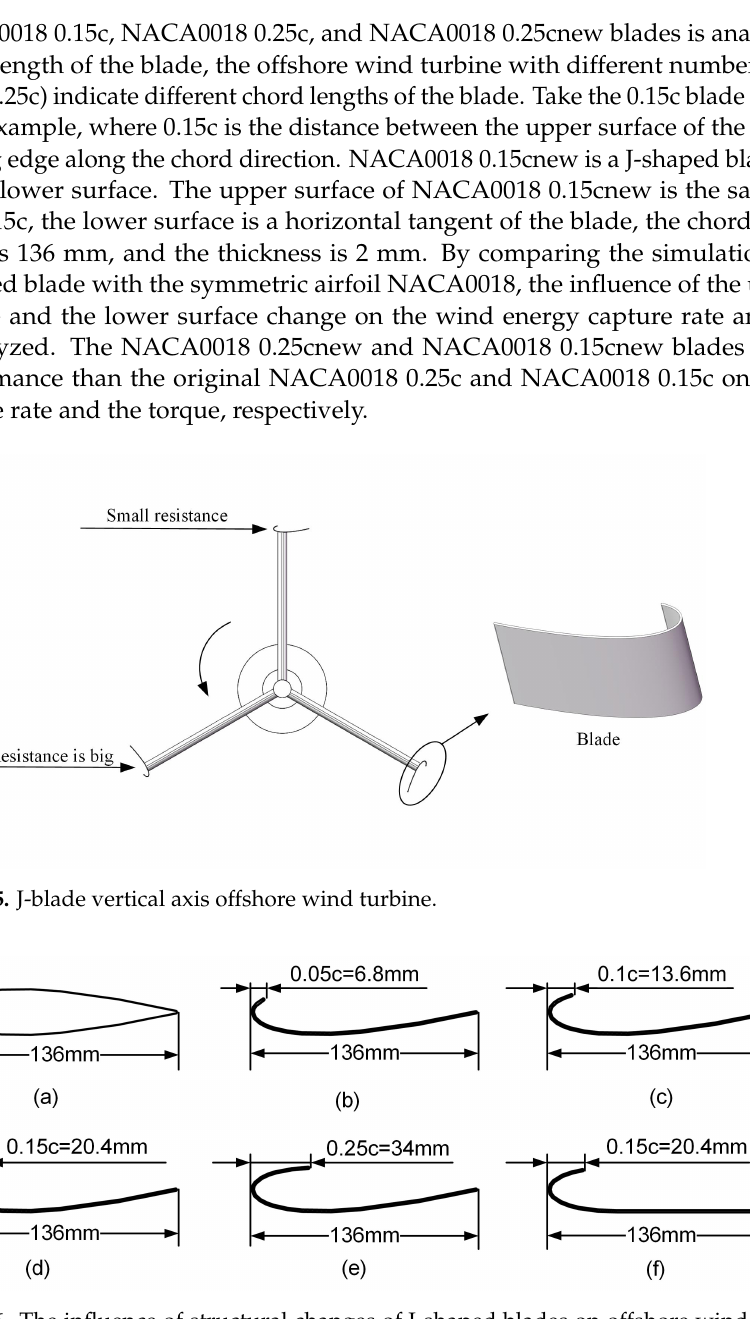
Figure 6. The influence of structural changes of J-shaped blades on offshore wind turbine perfor- mance. ( a ) the structural of J-shaped blades, ( b ) the structural (0.05c = 6.8 mm) of J-shaped blades, ( c ) the structural (0.01c = 13.6 mm) of J-shaped blades, ( d ) the structural (0.15c = 20.4 mm) of J-shaped blades, ( e ) the structural (0.25c = 34 mm) of J-shaped blades, ( f ) the structural (0.15c = 20.4 mm) of J-shaped